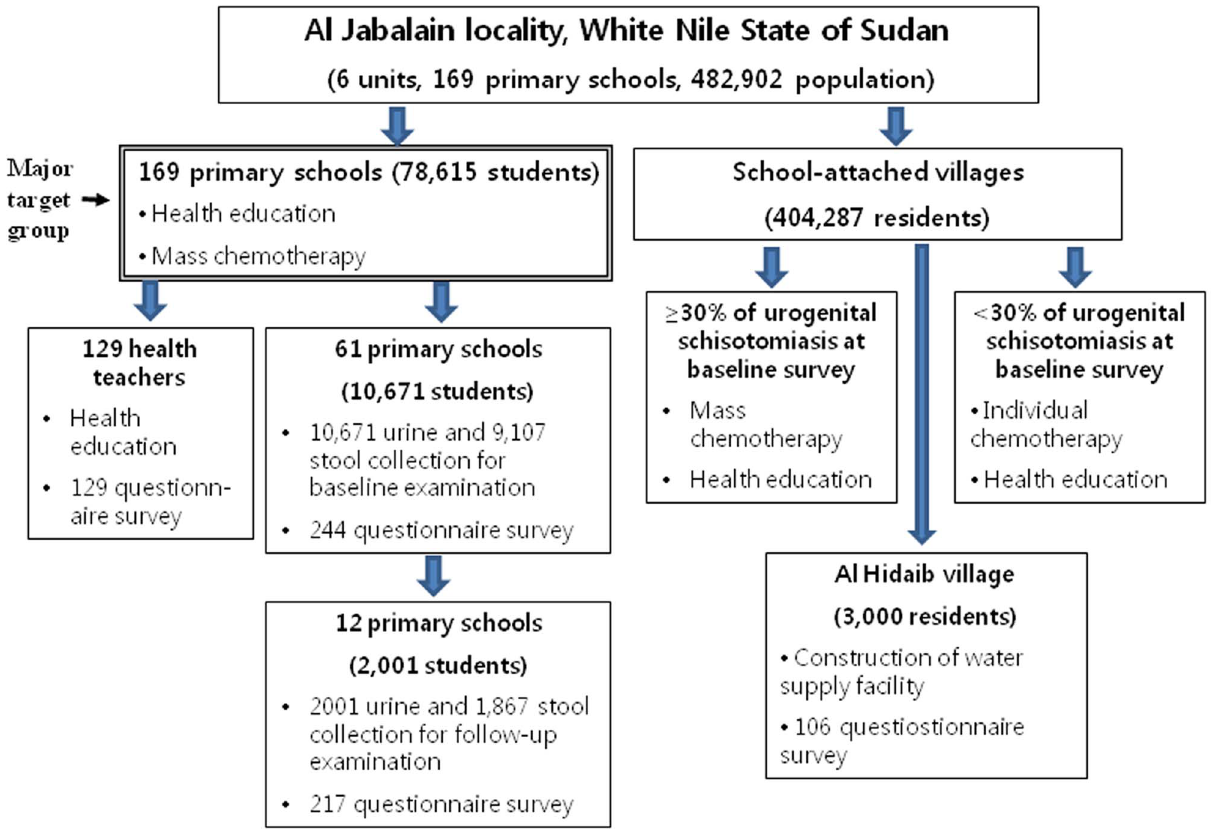
Fig. 3. Flow chart of the participation and adherence in the present study. This project was carried out at Al Jabalain locality of White Nile State in Sudan from August 2009 to June 2011. The study areas included a total of 169 primary schools and 482,902 individuals, including 78,615 primary school students. For baseline survey, 10,671 urines and 9,107 stools were collected from 10,671 students of 61 primary schools before treatment. For follow-up evaluation, 12 schools were randomly selected among 61 schools for baseline survey, and 2,001 urines and 1,867 stools were collected from 2,001 students. According to the results of baseline survey of primary school belonging the village, village residents were received the different patterns of chemotherapy and health education.